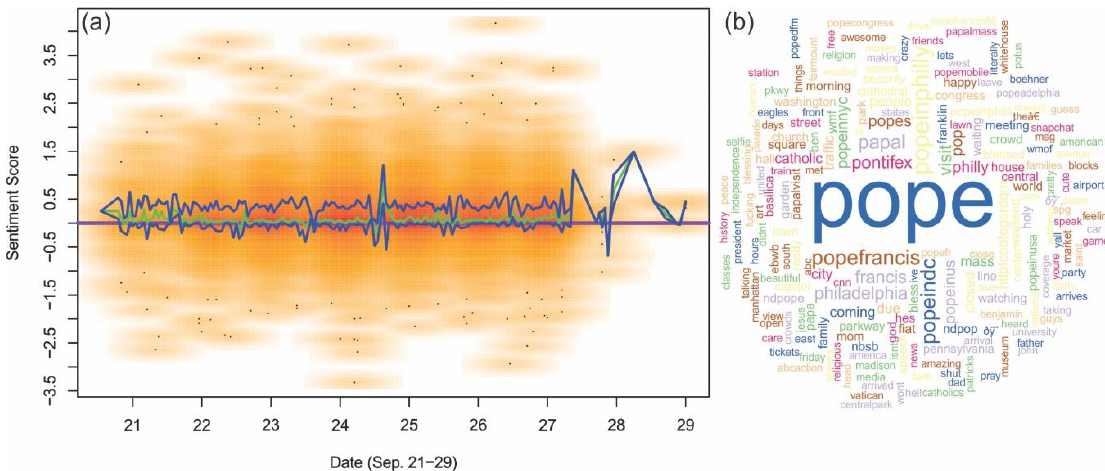
Figure 10. ( a ) Scatter plot depicting the sentiments from the tweets about the Pope’s visit. The purple line represents a neutral sentiment; below the purple line represents negative sentiments and above the purple line represents positive sentiments. The two blue curves wrapping around the green curve are lower quartile and higher quartile. The darker color represent higher tweet temporal density. ( b ) Word cloud of keywords from tweets related to the Pope’s visit.